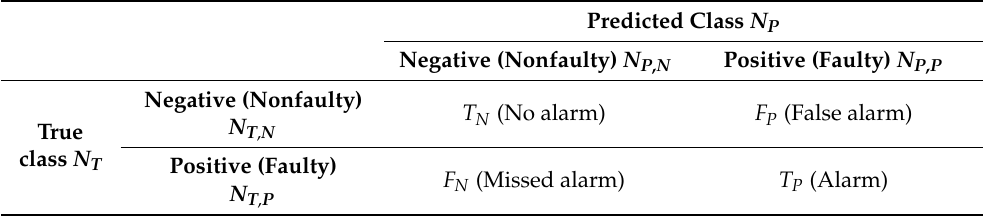
Table 9. Proposed generalized definition template for confusion matrix of FD (one faulty and one nonfaulty class).